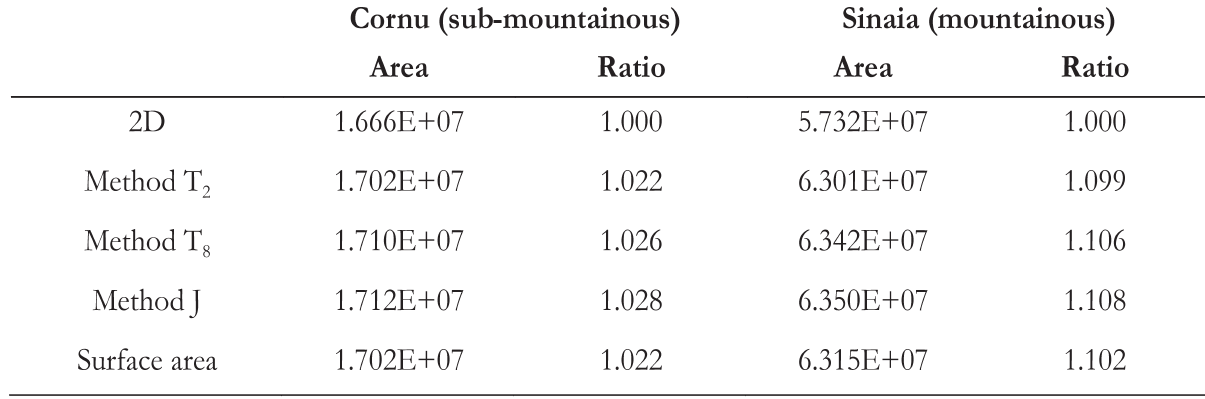
Table 2. Area estimations and ratios between the 3D-approximation and the 2D-value in the case of the two test land- scapes (surface areas are expressed in m 2